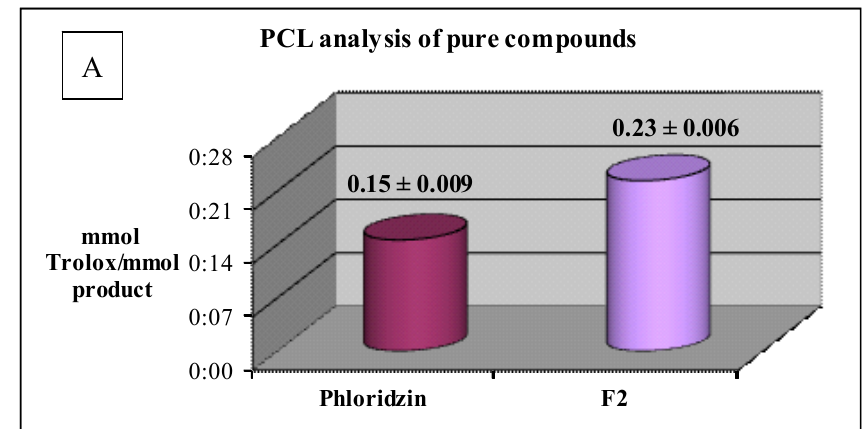
Figure 3. Panel A : PCL analysis of phloridzin and F2. Panel B : PCL analysis of phloridzin and F2 formulations. Each value was obtained from three experiments (Mean ±